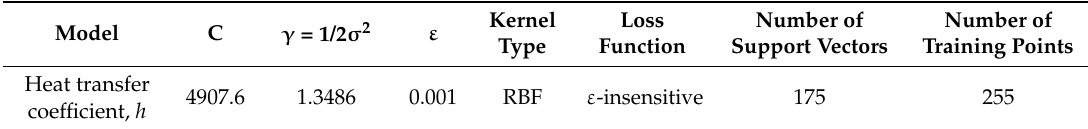
Table 3. Optimal parameters of the SVR model for the prediction of heat transfer coefficient of R600a.